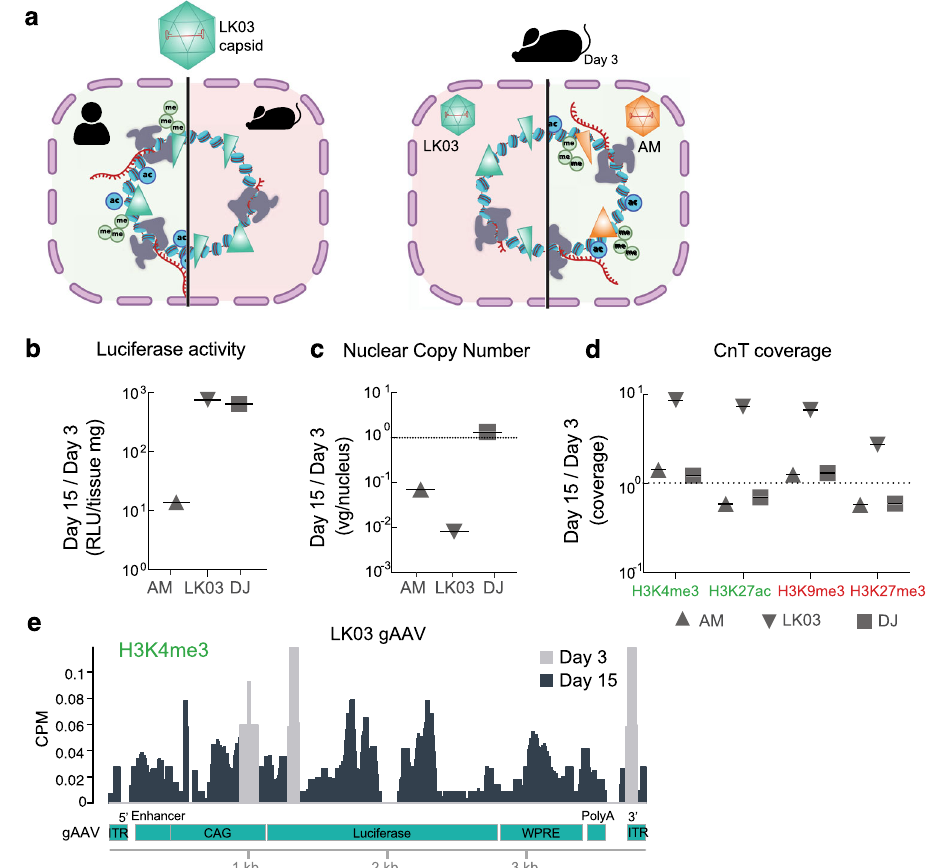
Fig. 4 | Species selectivity of AAV-LK03 mediated transgene expression involvestheformationofactive-relatedhistoneepigeneticmarks.a Schematic representation of results (created with BioRender.com). AAV-LK03 derived gen- omes were enriched for active-related epigenetic marks in human, but not mouse cells. After adding a single amino acid to the AAV-LK03 capsid (AAV-AM), trans- ductionwasef fi cientinmousecellsandliver.Active-relatedepigeneticmarkswere enriched in AAV-AM transduced mice. b – d Ratio comparisons of in vivo assays on